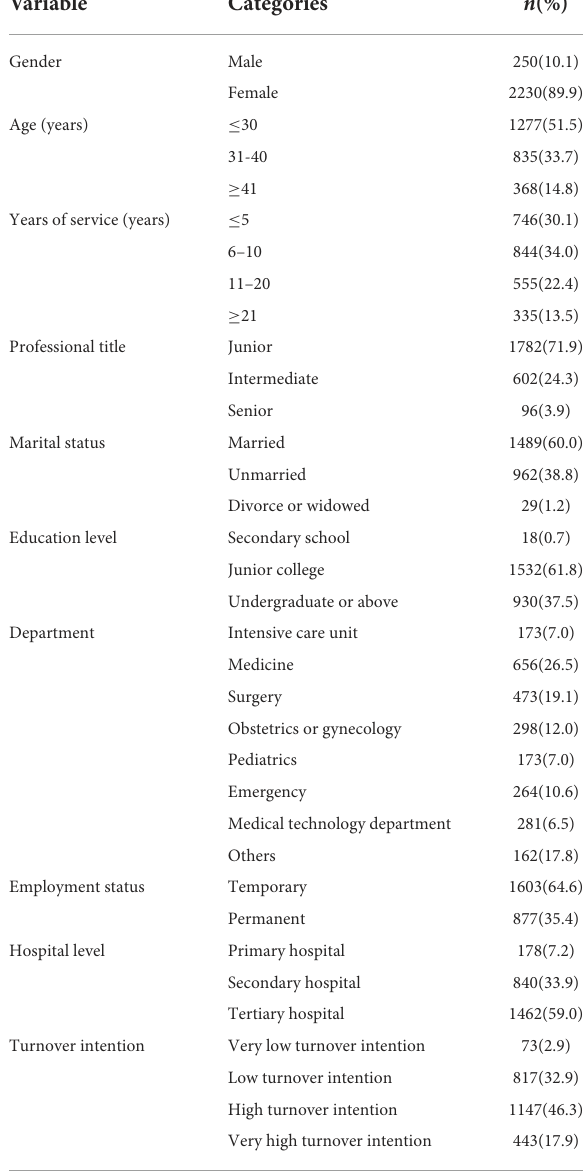
TABLE 1 Demographic characteristics of participants( N =